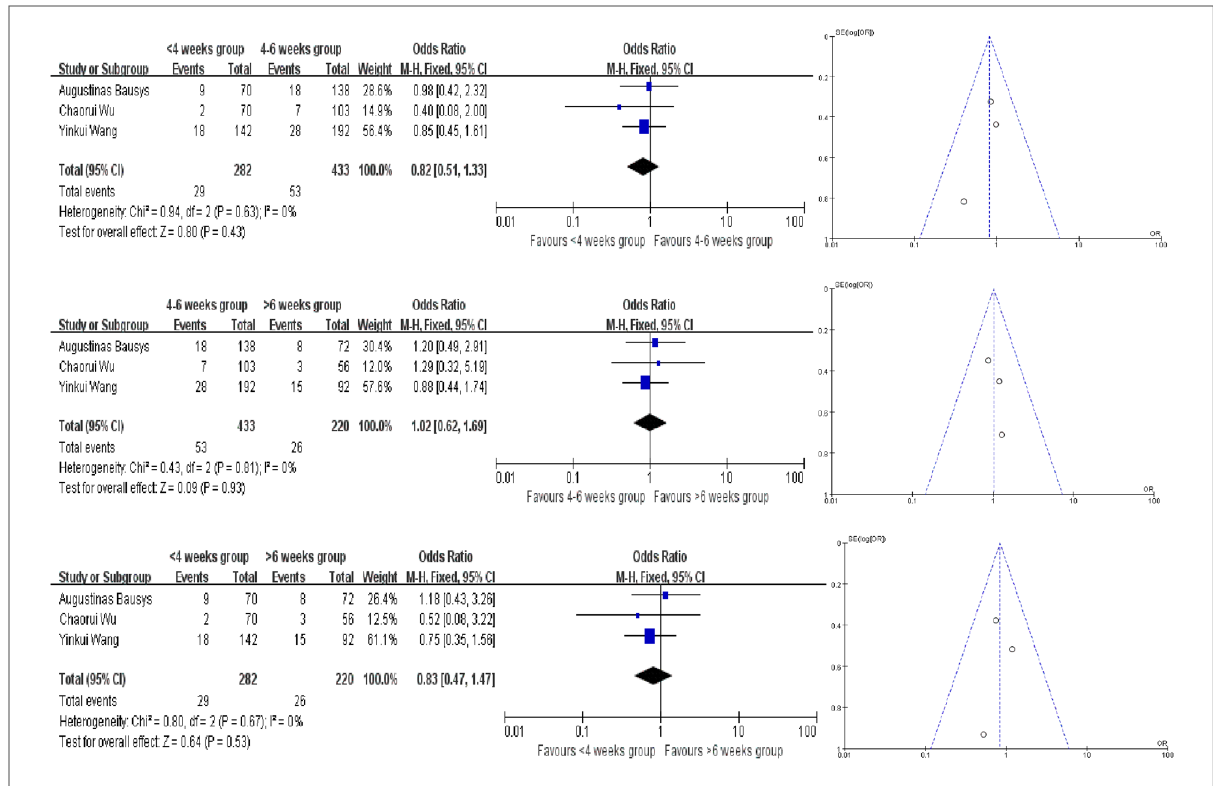
FIGURE 4 Forest plot and funnel plot for severe postoperative mortality rates meta